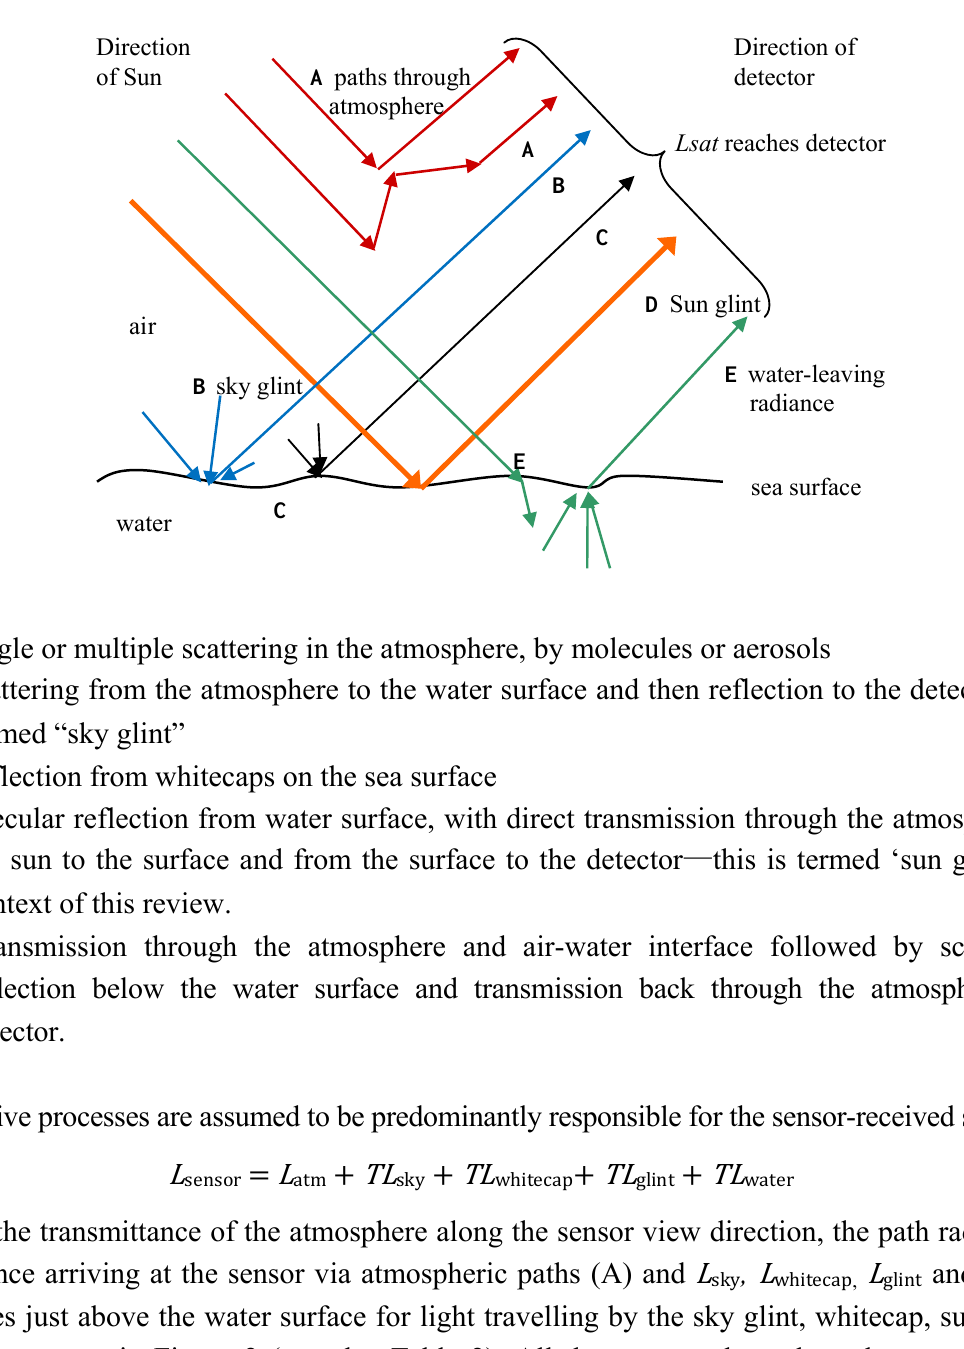
Figure 2. Schematic diagram showing routes by which light can reach a remote sensing